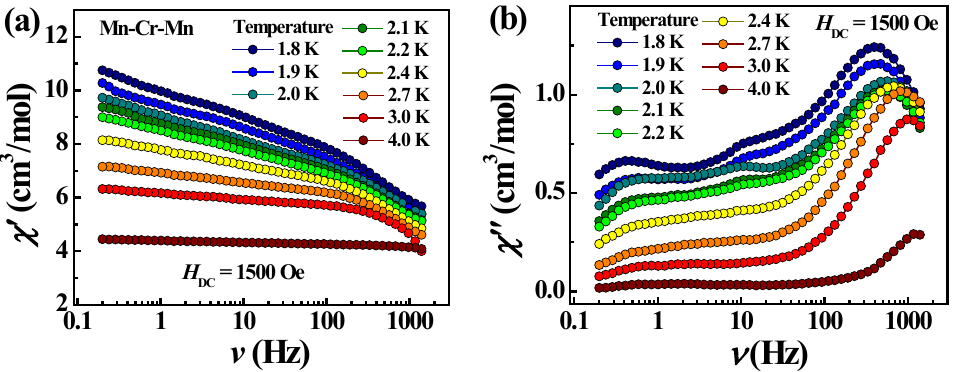
Figure 11. Frequency dependencies of χ ’ ( a ) and χ″ ( b ) at different temperatures for complex 3 in 1500 Oe dc field.